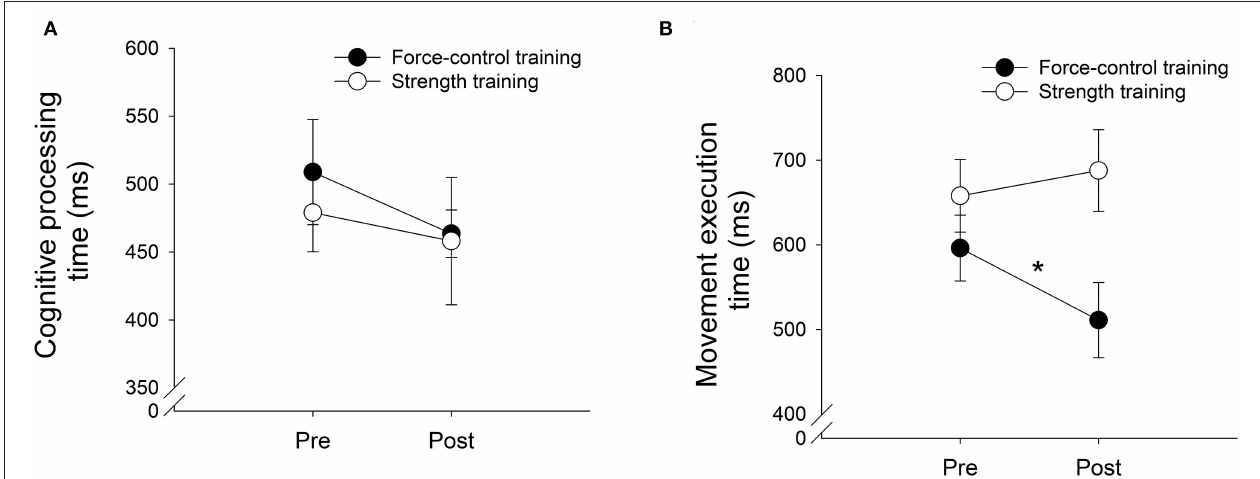
FIGURE 2 | The cognitive processing time (A) and movement execution time (B) after force-control training (closed circle) and strength training (open circle). The cognitive processing time did not decrease significantly after for both motor interventions (A) . The movement execution time significantly reduced after force-control training but not after strength training (B) .